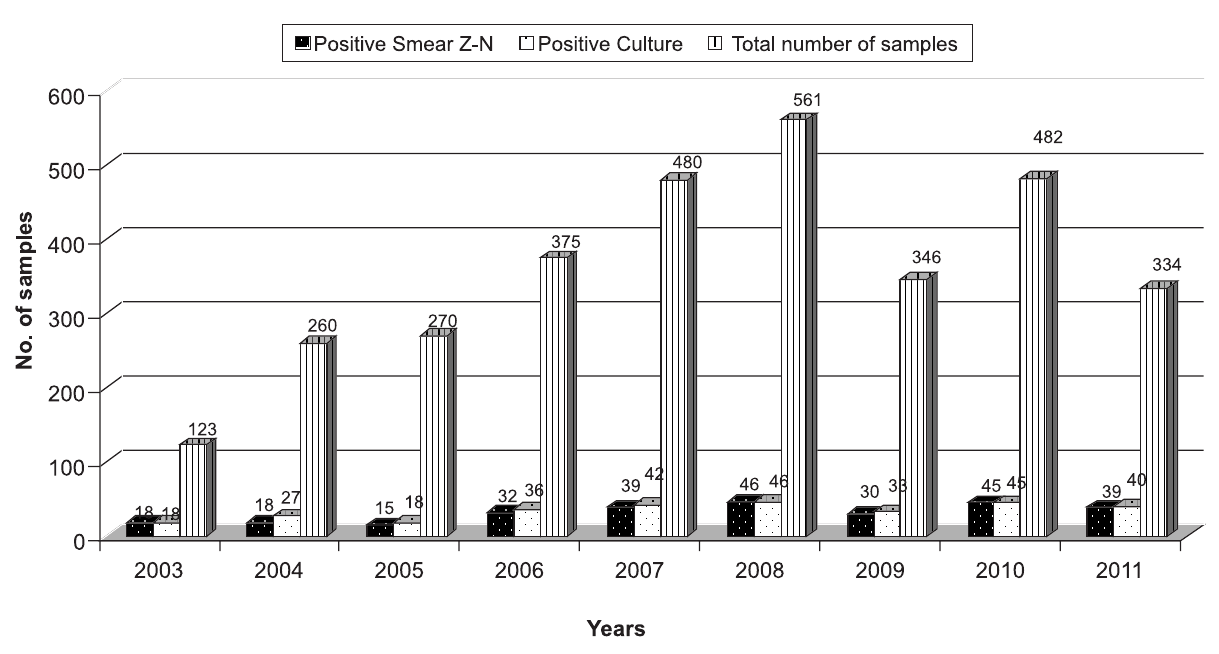
FIGURE 1 - Positive Z-N smears and cultures of sputa samples from suspected TB patients processed from 2003 to 2011 in the Laboratory of Medical Bacteriology, Laboratory of Teaching and Research in Clinical Analysis, State University of Maringá, Paraná,